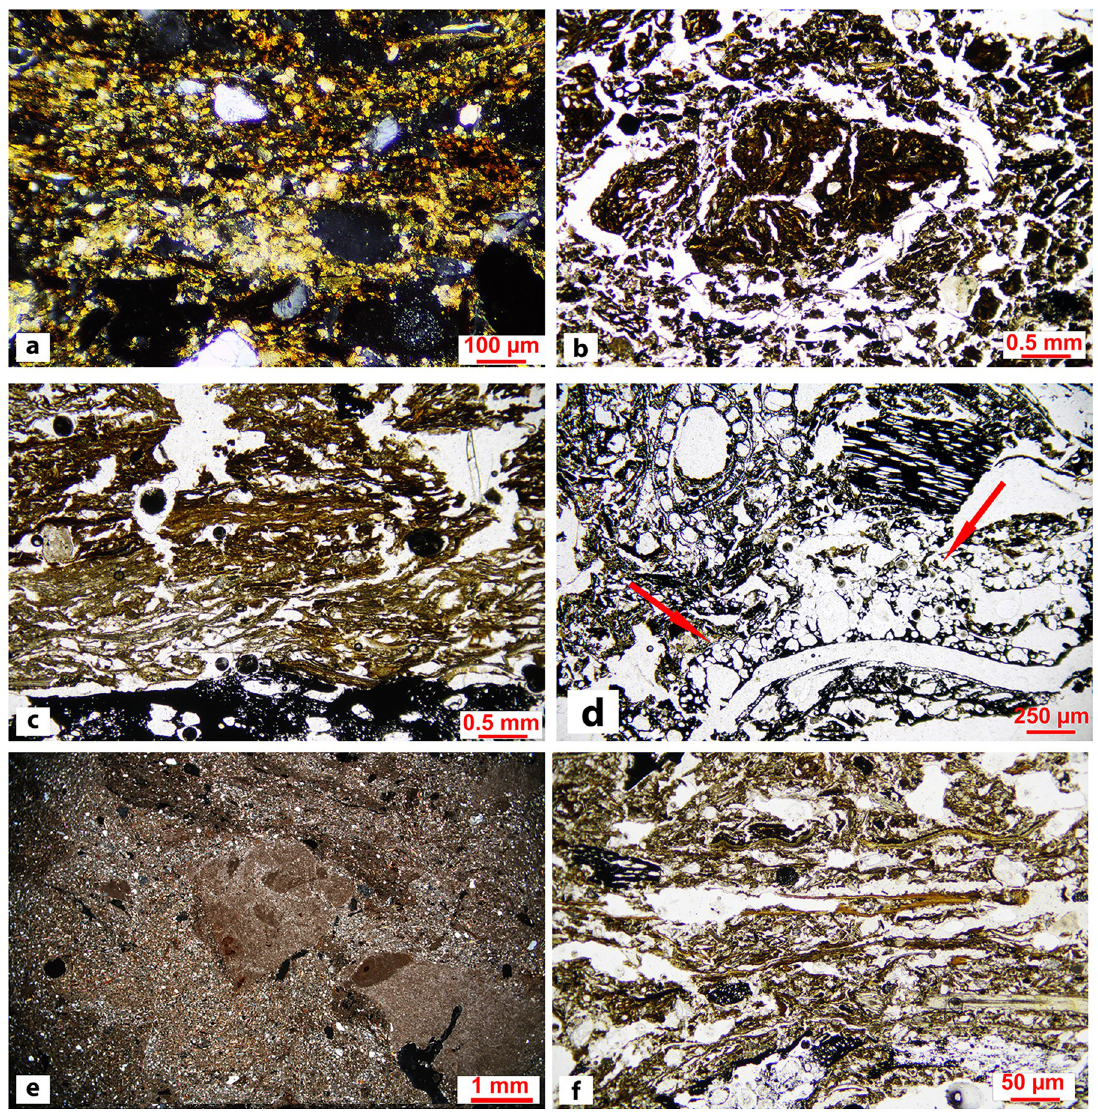
Fig 7. Microphotographs of SMT 2, its sub-types, SMT 3, SMT 4a, and SMT 5. (a) SMT 2: wood ash at the center of the image (brighter area) sandwiched between compacted and aligned herbivore dung. Note the presence of fecal spherulites in dung (XPL); (b) SMT 2a: non-compacted herbivore dung. Note the fragmented small herbivore coprolite, probably related to goat/sheep (PPL); (c) SMT 2b: compacted and aligned (i.e., trampled) herbivore dung on top of a charcoal fragment. (PPL); (d) SMT 3: Wood tar particle (red arrows) surrounded by charcoal and charred vegetal fragments. Note the numerous vesicles in the wood tar (PPL); (e) SMT 4a: heterogeneous hearth preparation made of silty sand/sandy silt sediments (cf. Fig 6E), including fine-grained calcareous aggregates (XPL); (f) SMT 5: gyttja floor. Note the massive microstructure and the abundance of vegetal fragments mixed with charcoal in a silty groundmass